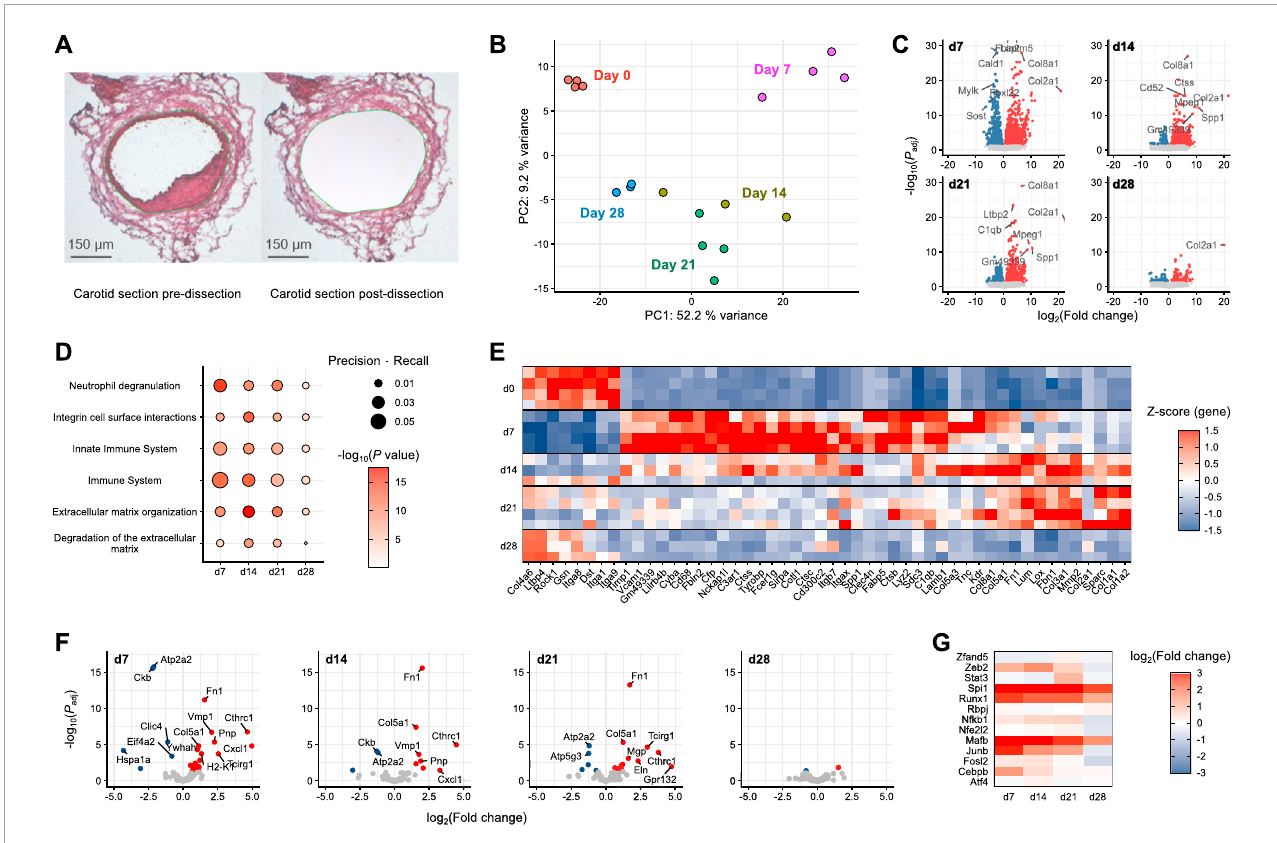
FIGURE 4 MACE-sequencing of neointimal tissue isolated from injured carotid arteries (A) Representative carotid section pre- and post-laser-capture microdissection (dissected area marked in green). (B) Principal component analysis of pooled neointima samples ( n = 3-4) from pre-wire injury (Day 0) and days 7, 14, 21 and 28 post-injury. (C) Volcano plots of each day post-injury with differentially expressed genes highlighted in either blue (downregulated) or red (upregulated). (D) Pathway enrichment analysis of differentially expressed genes at each time point post-injury versus day 0 (pre-injury). (E) Top 50 differentially expressed genes assigned to significantly enriched pathways. (F) Volcano plots of SEM cluster marker genes as identified in scRNA-seq. (G) SEM-enriched transcription factor gene log fold changes in carotid neointima on days 7, 14, 21 and 28 post-wire injury versus day 0